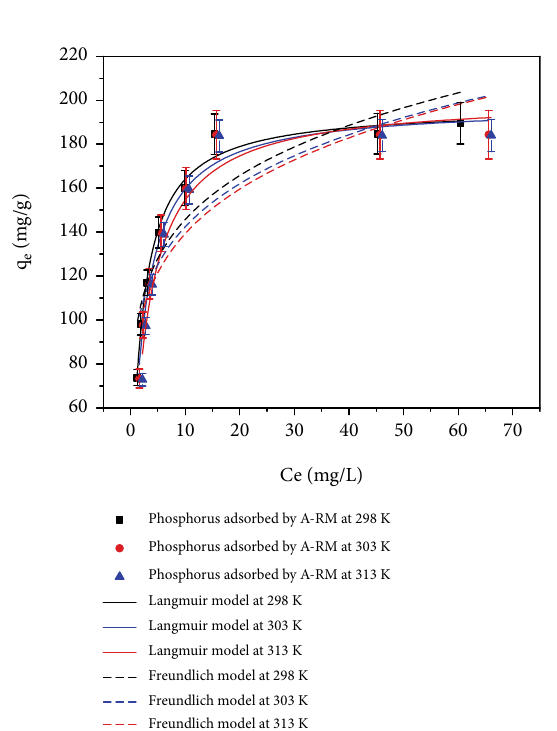
q e and e of phosphorus